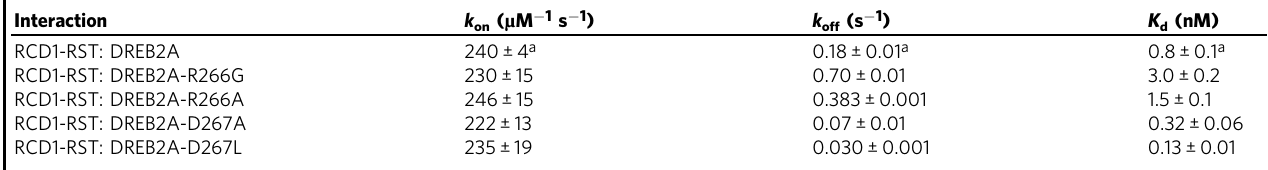
Recorded at 10°C in 50mM HEPES, 100mM NaCl, pH 7.4. Raw data available as Supplementary Data 4. ± Standard error from fi